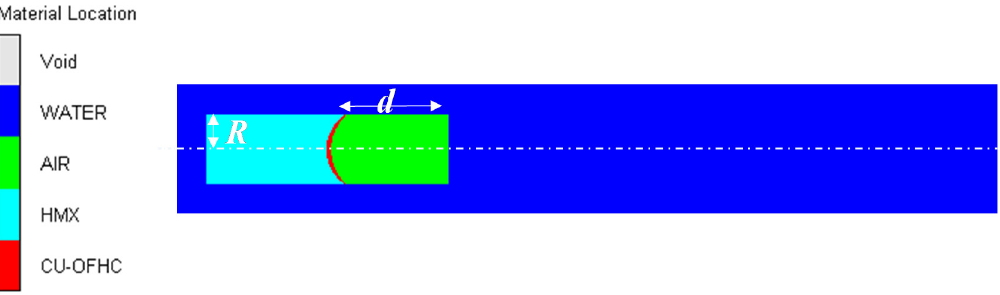
Figure 4. The length of this air cavity d dramatically affected the formation and velocity of the projectile. Sun et al. [32] found that when its length was three times the charge radius, the shape of the EFP in the formation process was better. In order to find out a better length of air cavity in this paper, three cases with d from two to four times the charge radius were chosen in Table 3.